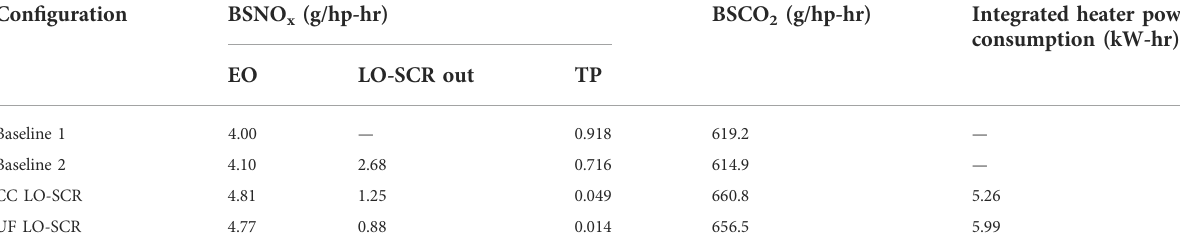
TABLE 7 LLC test results.